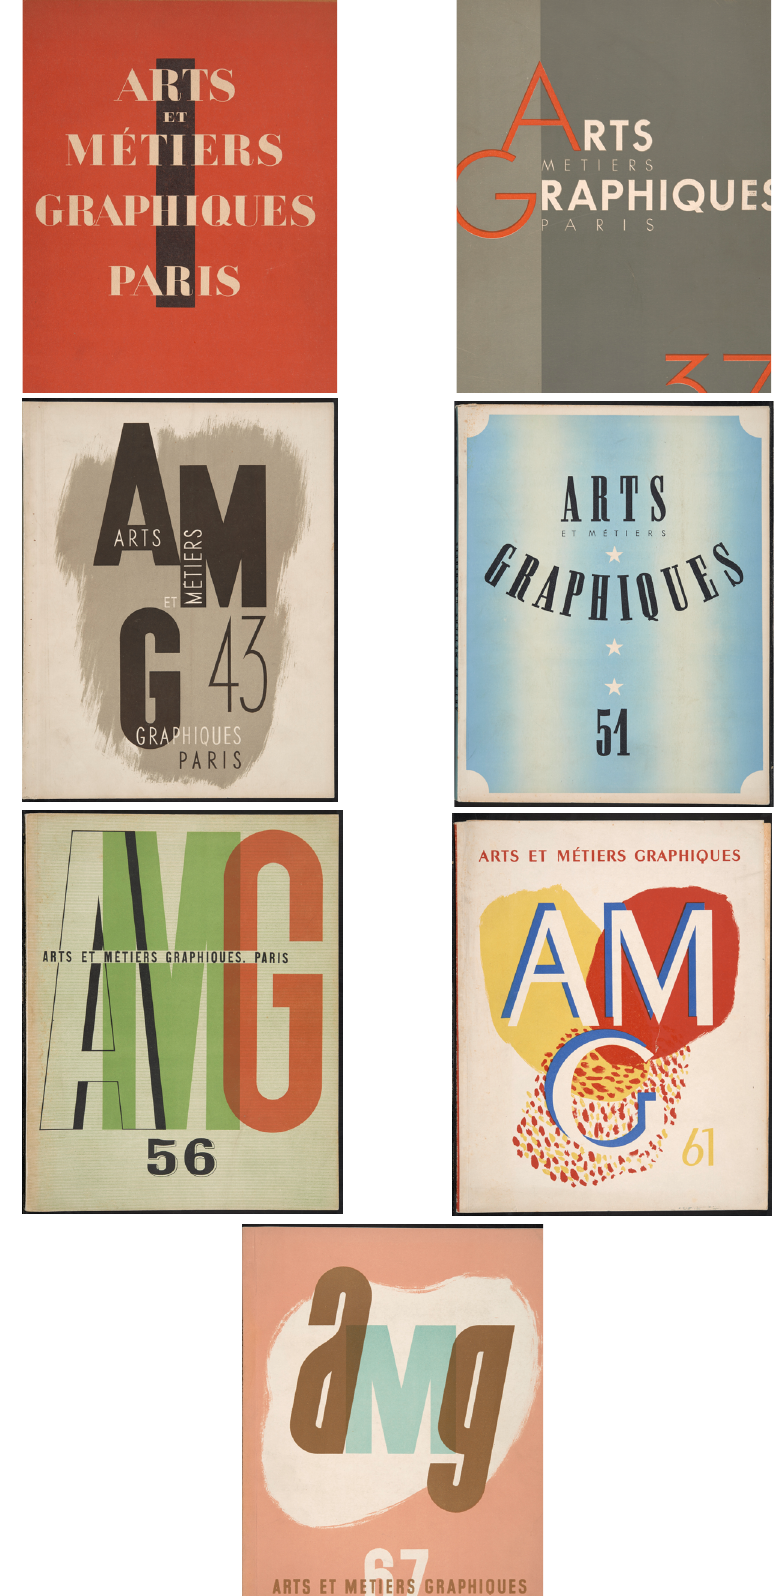
Fig. 1 Different covers of AMG throughout the